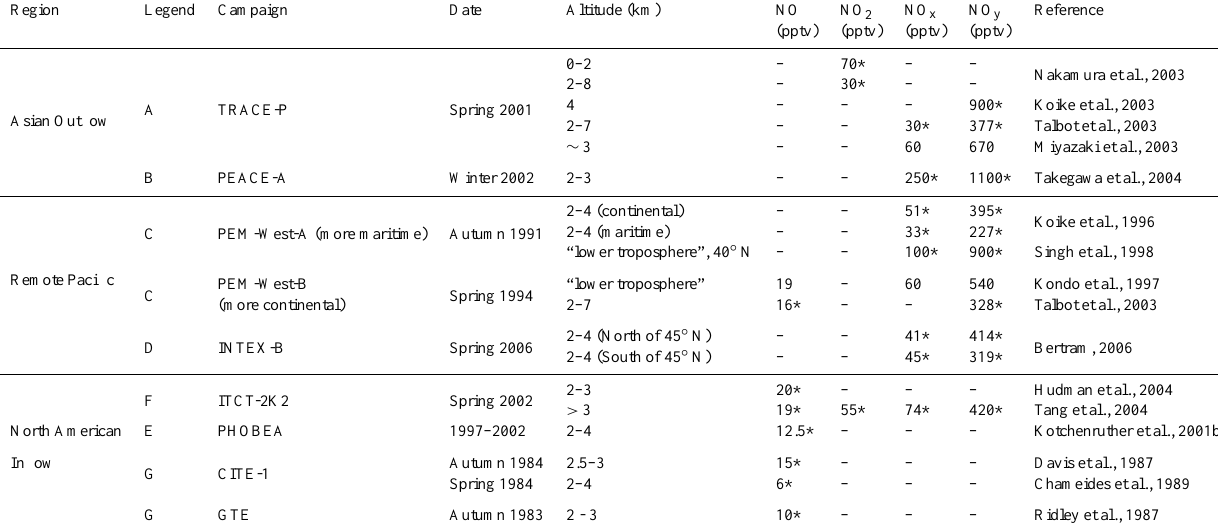
Fig. 6. Geographic location of aircraft campaigns (depicted by shaded boxes and letters) studying pollution outflow from Asia, its transfor- mation over the Pacific and its influence on inflow to North America. See Table 3a for details. Geographic location of Northern Hemisphere mid-latitude mountain sites (depicted by stars and numbers) with NO and/or NO x observations. See Table 3b for details. Table 3a. Details on aircraft campaigns studying Asian pollution transport depicted in Fig. 6 along with NO, NO 2 , NO x and NO y data where available. Values denoted with an asterisk (*) are means; all other values are